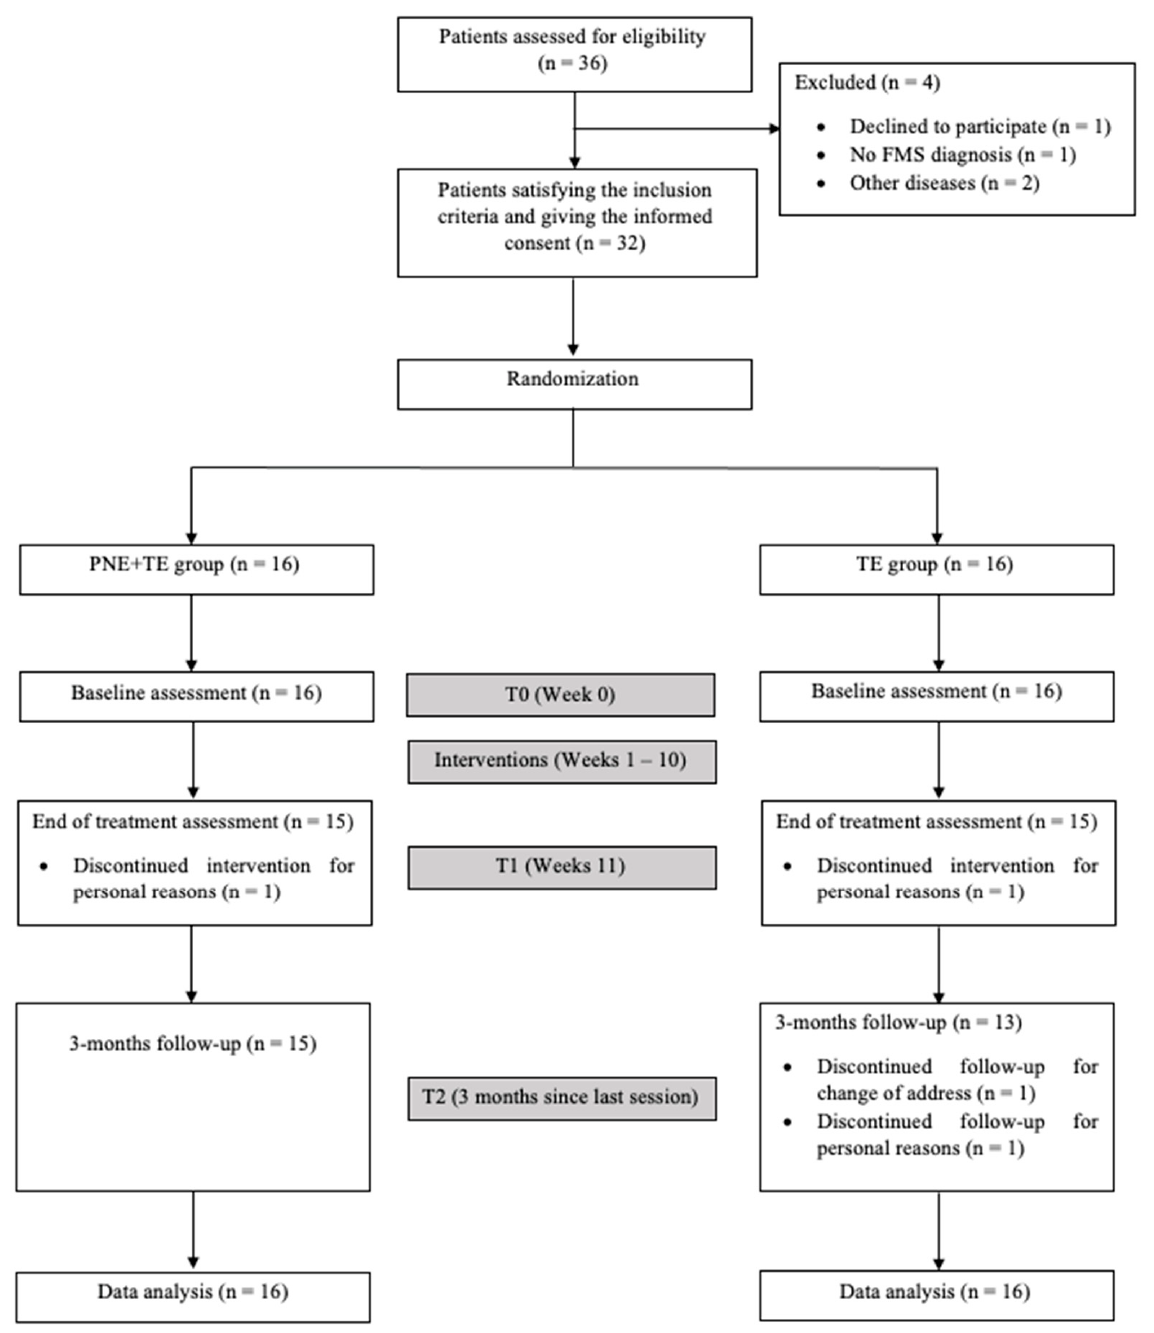
Figure 1. Flowchart diagram.